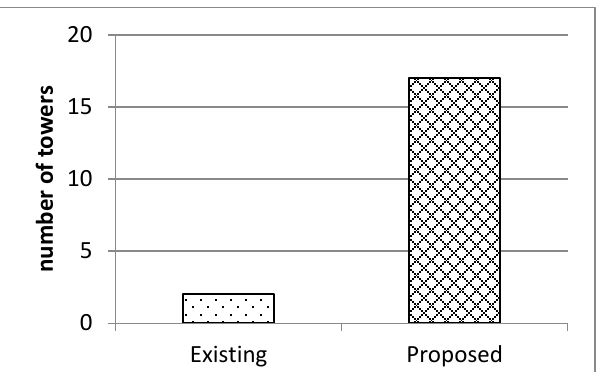
Figure 4. Comparison of the number of residential towers for the existing and proposed development.